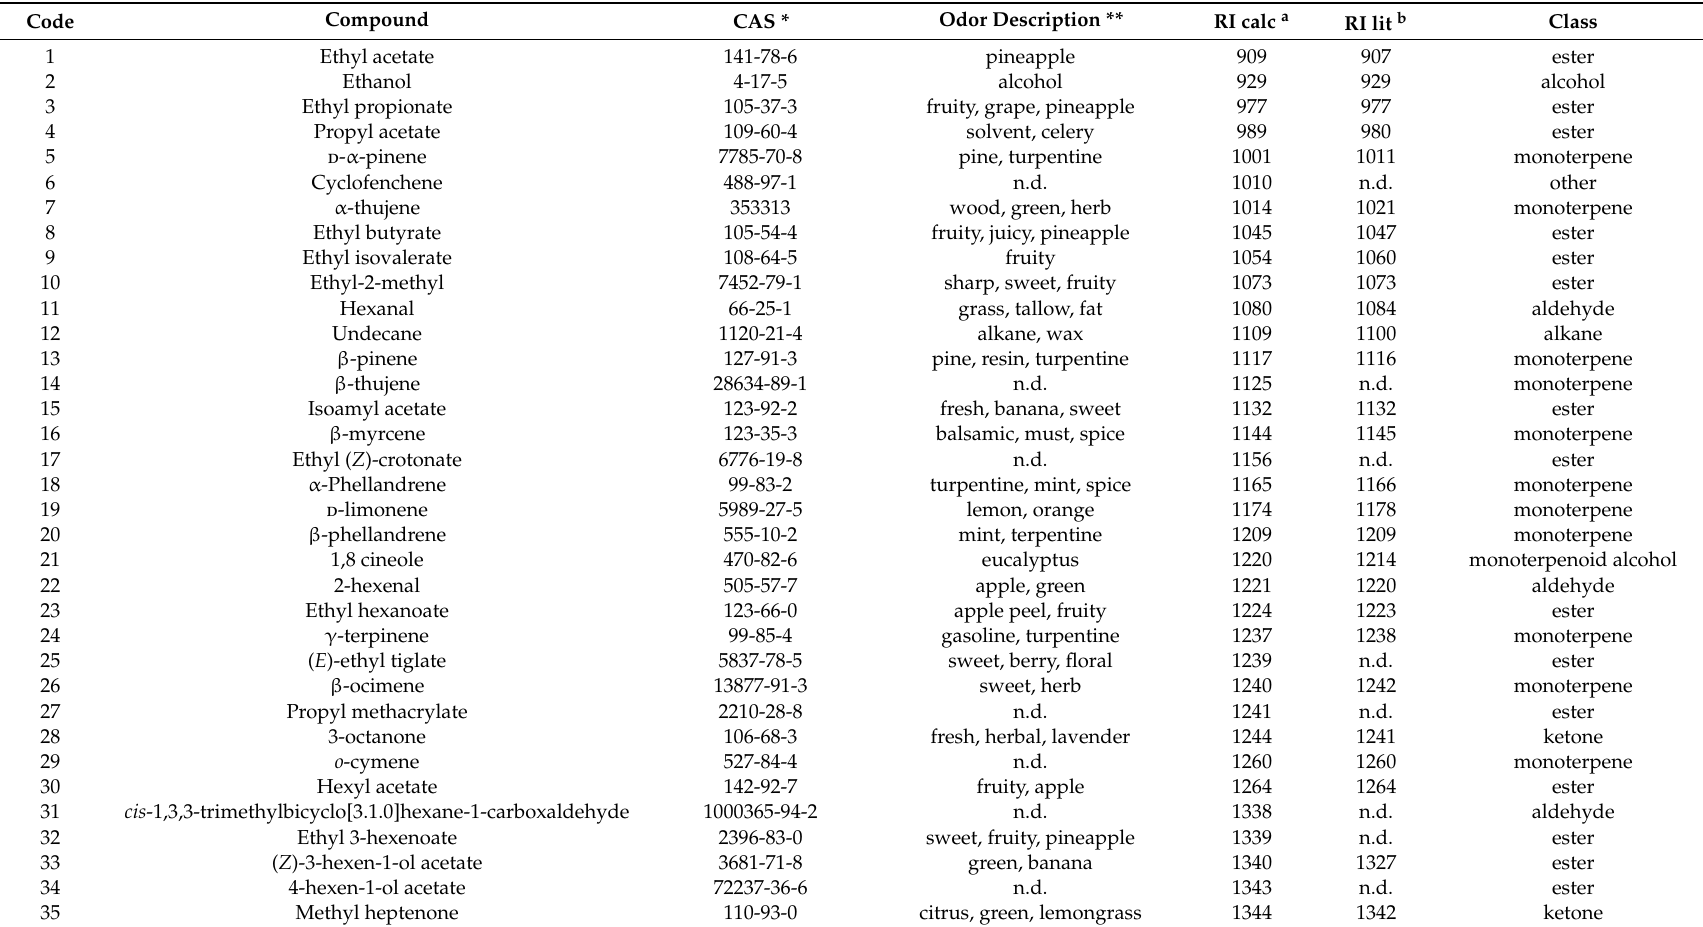
Table 1. List of volatile aroma compounds found in ‘Sabar á ’ ( Plinia jaboticaba ), ‘Escarlate’ ( Plinia phitrantha × Plinia cauliflora) , ‘Otto Andersen’ ( Plinia cauliflora ), and ‘Esalq’ ( Plinia phitrantha ) jabuticabas by headspace solid-phase microextraction combined with gas chromatography / mass spectrometry